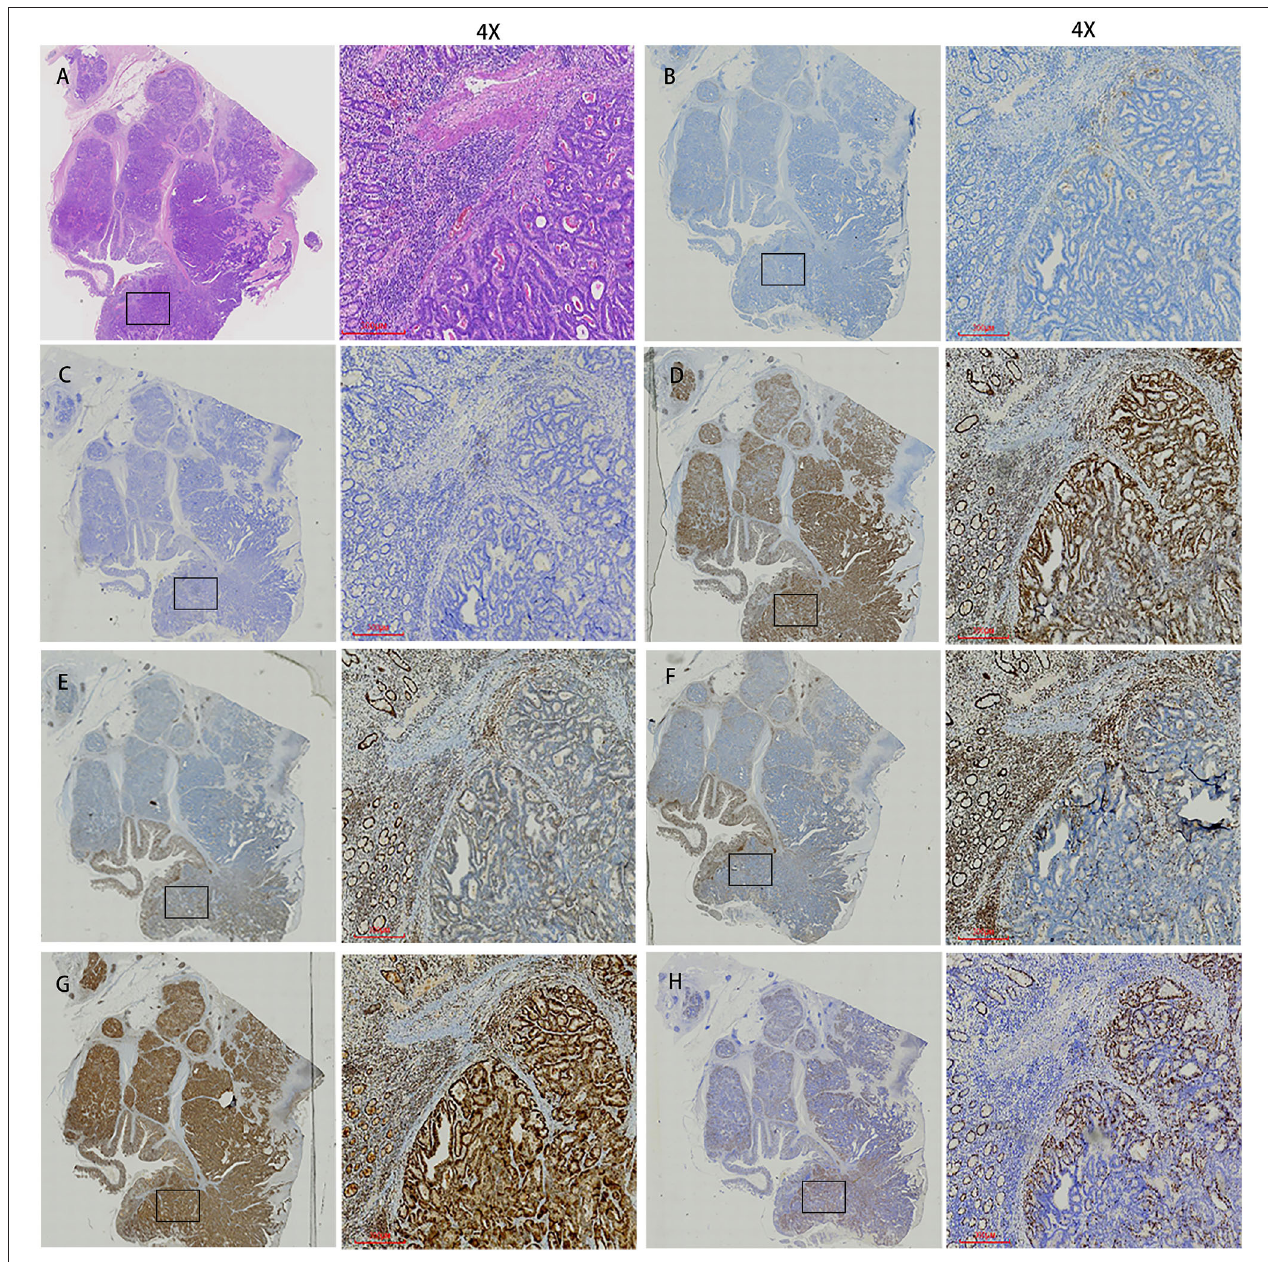
FIGURE 3 | Histopathological findings and immunohistochemistry. (A) Histological findings showed tumor cells with cytoplasm rich in eosinophilic granules and clear nucleoli that showed dense proliferation. (B) PD-1. (C) PD-L1. (D) MLH1. (E) MSH2. (F) MSH6. (G) PMS2. (H) Ki67. The first image in each group was viewed from a macro perspective. The scale bars of second picture in each group was 300 µ